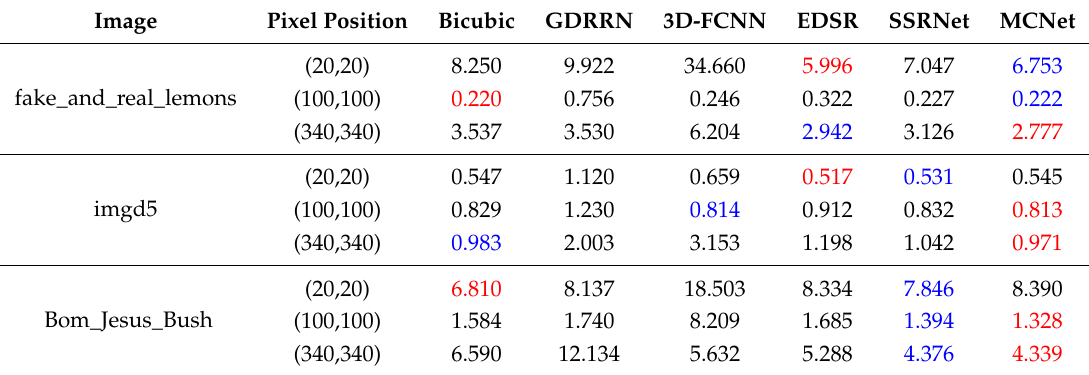
Figure 12. Visual comparison of spectral distortion for image Bom_Jesus_Bush on Foster dataset. ( a – c ) Results of the spectral curve in pixel position (20, 20), (100, 100), and (340, 340). Table 4. Spectral distortion comparisons in three scenes by SAM. The red and blue indicate the best and second performance,